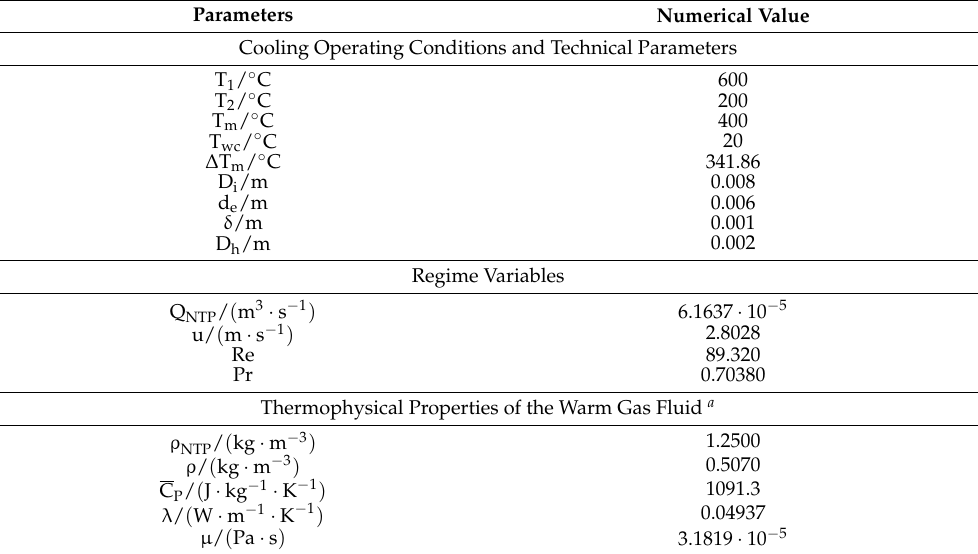
Table 3. Values of parameters used for calculation of the fast-quenching system length and of the required cooling duration a .